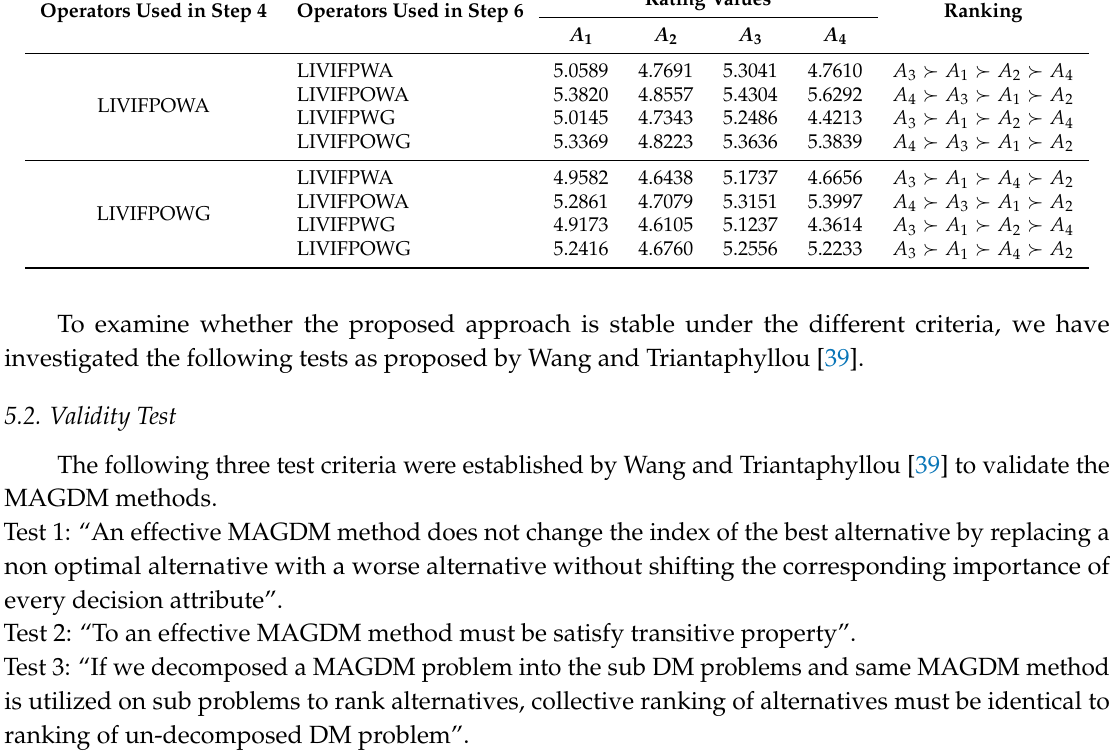
Table 7. Worse alternative A (cid:48)